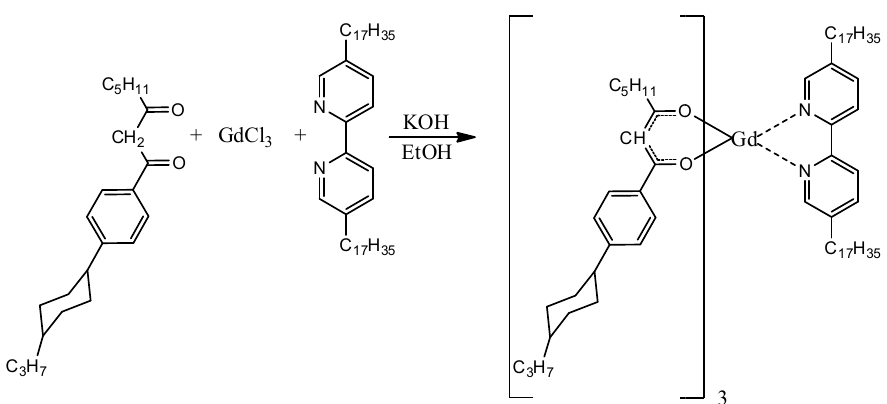
Figure 1. The chemical structure and synthesis procedure of the investigated material.